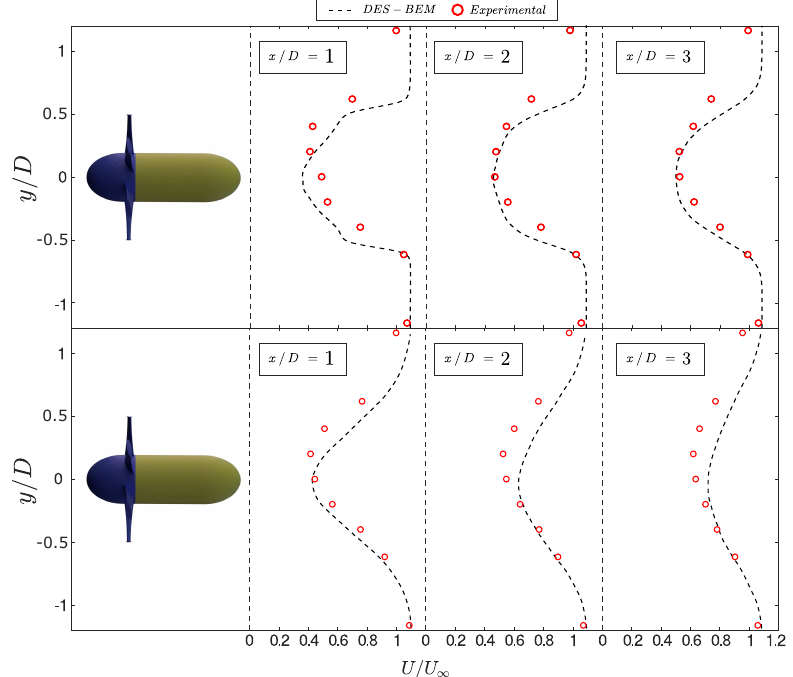
Figure 4. Transverse velocity profiles for the first three diameters of distance downstream of the primary turbine for the ( top ) ST and ( bottom ) TT cases. The DES-BEM model shows agreement with the experimental profiles, but the model is not capable of representing the asymmetry observed in the